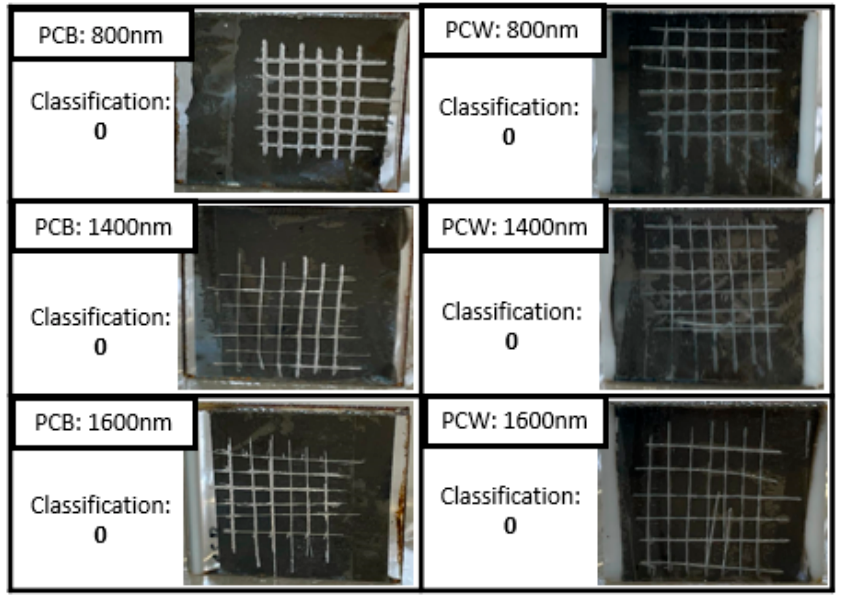
Figure 9. Representative images of the adhesion of the Cr coatings to the substrates, with the respective classification.